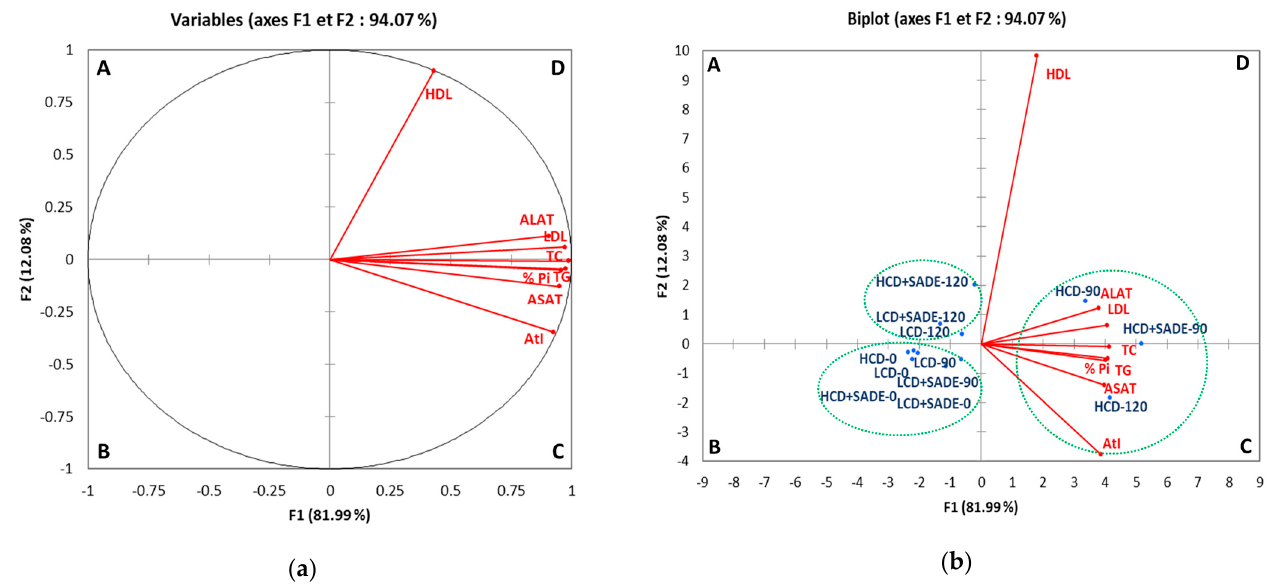
Figure 8. Biplot of objects and component loads for grouping of biochemical descriptors (TC, TG, HDL, LDL, AtI, ASAT, ALAT, and % Pi) ( a ) and animal groups samples ( b ). LCD: animals group fed with natural low-calorie vegetable diet, LCD + SADE: LCD treated with S. arabica decocted, HCD: rats fed with high-calorie diet and HCD + SADE: rats fed with high-calorie diet treated with S.